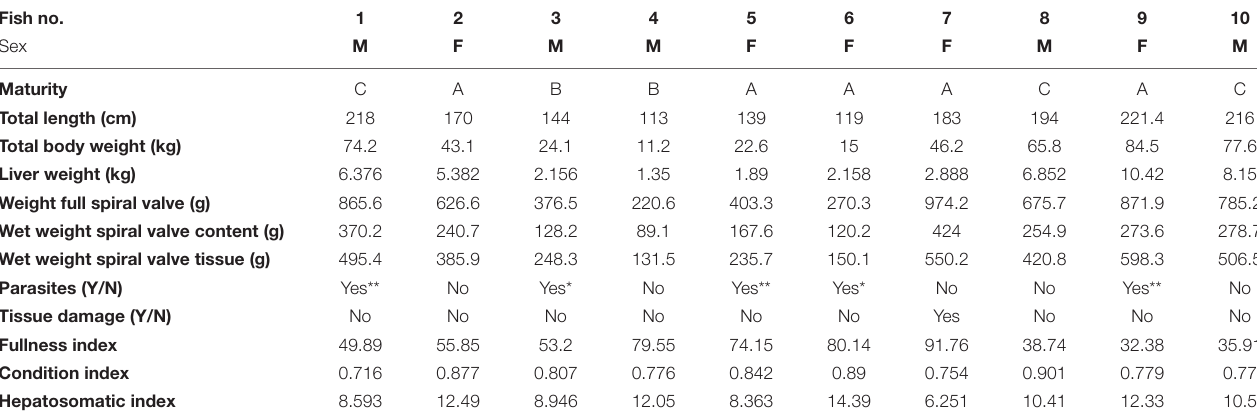
TABLE 1 | Overview of measurements during sampling and sample collection. Fish